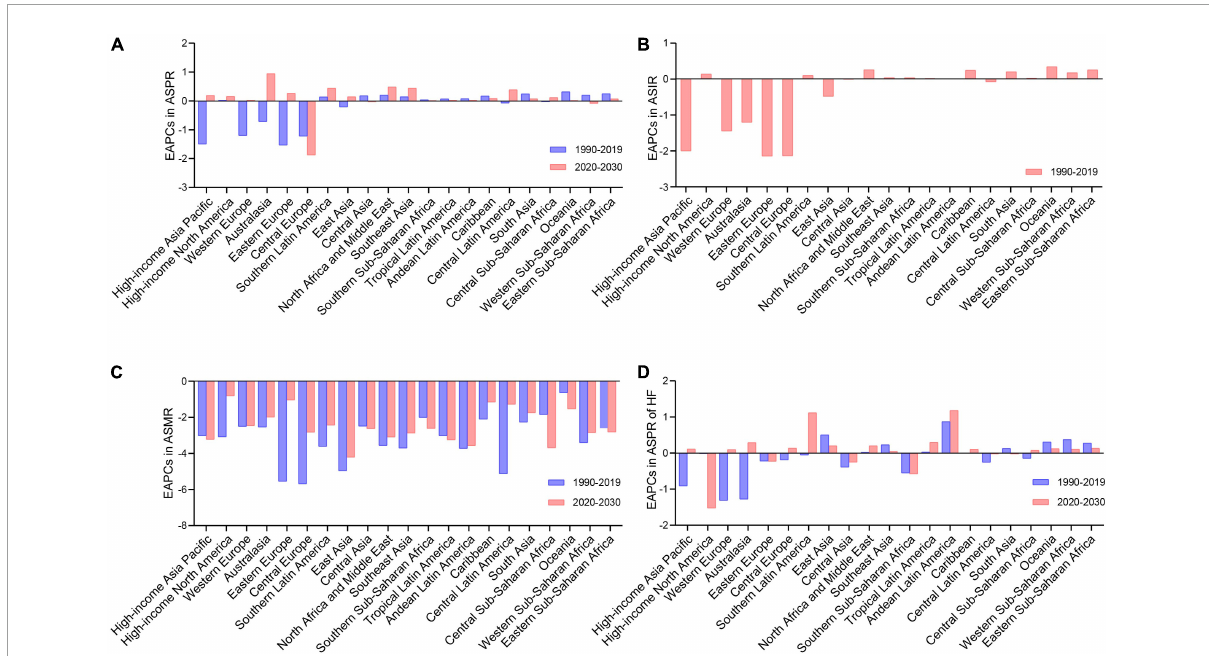
FIGURE2 The change trends of the RHD-related disease burden in 21 GBD regions. (A) The EAPCs in ASPR between 1990–2019 and 2020–2030. (B) The EAPCs in ASIR between 1990 and 2019. (C) The EAPCs in ASMR between 1990–2019 and 2020–2030. (D) The EAPCs in ASPR of HF between 1990–2019 and 2020–2030. RHD, rheumatic heart disease; GBD, global burden of disease; EAPCs, estimated annual percentage changes; ASPR, age-standardized prevalence rate; ASIR, age-standardized incidence rate; ASMR, age-standardized mortality rate; HF, heart failure.